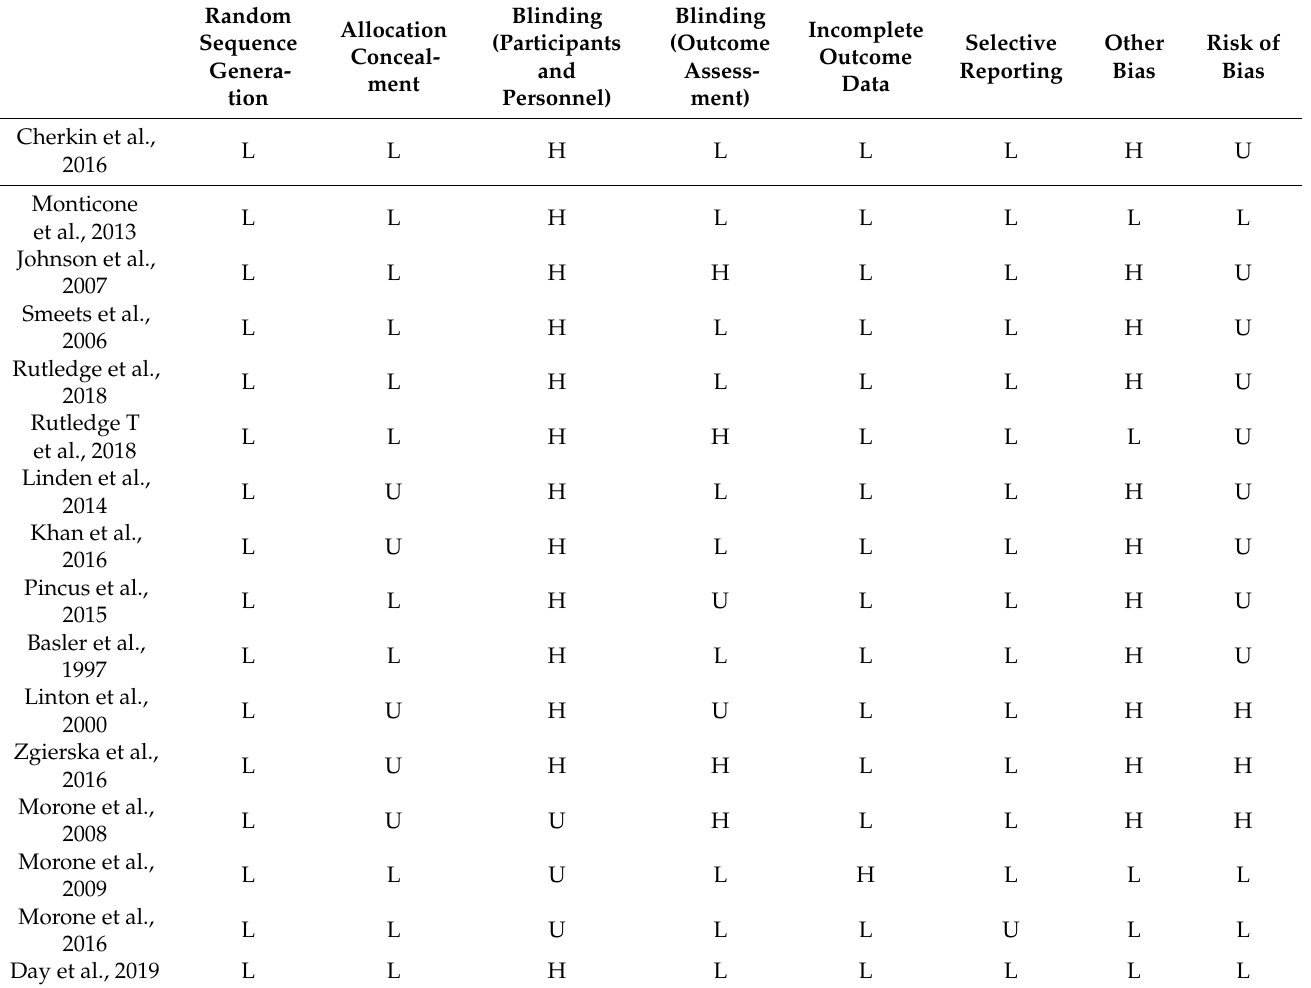
Table 3. Cochrane risk-of-bias tool for randomized controlled